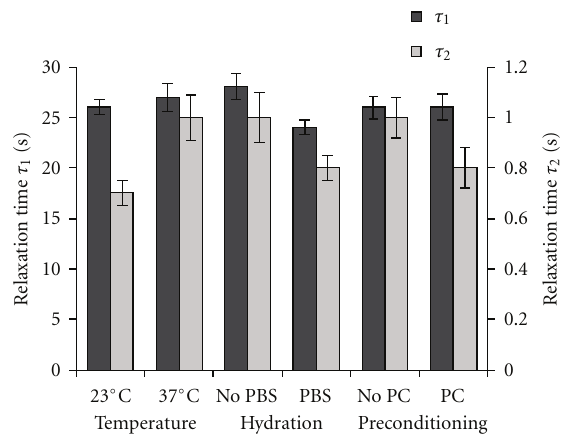
Figure 8: Relaxation times of ring-shaped collagen gels as a function of temperature (experiments performed either at 23 ◦ C or 37 ◦ C), hydration (either with or without a PBS solution), and mechanical preconditioning (either with or without mechanical preconditioning PC). τ 1 and τ 2 are the relaxation times of the gels considered in the viscoelastic model. Values are expressed as mean ± standard error. Significance: ∗ P < 0 . 05; ∗∗ P < 0 . 01; ∗∗∗ P < 0 . 001.